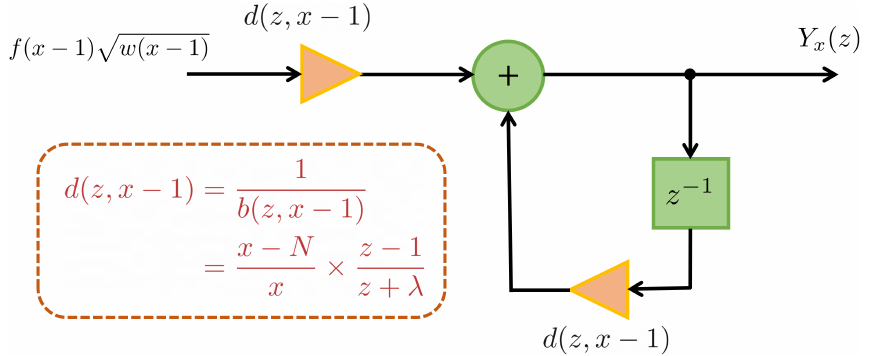
Figure 4. 1D digital filter structure to generate Y x ( z ) based on Equation